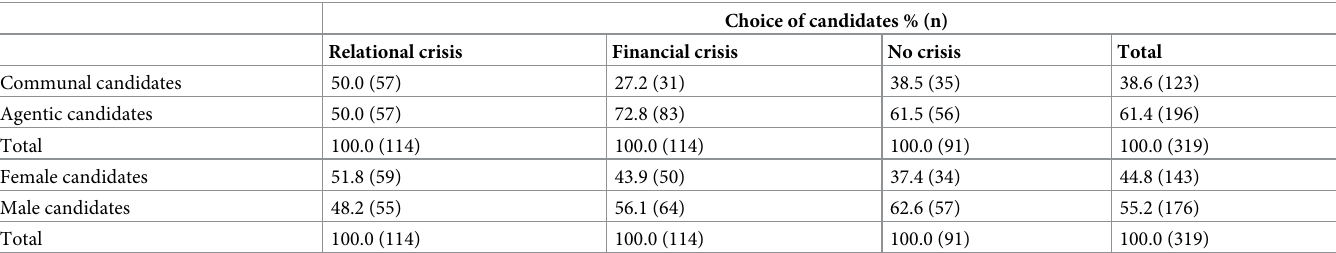
Table 1. Choice of a communal versus agentic and female versus male candidates as a function of type of crisis (Study 1, Spain).